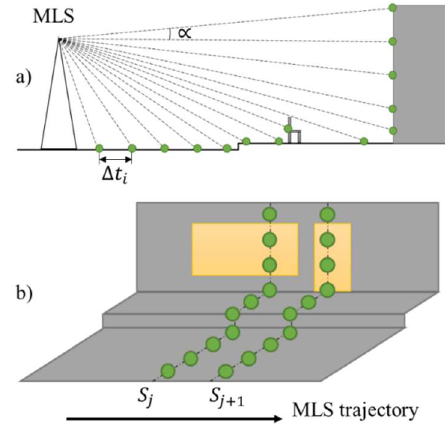
Figure 2: Scanlines of a street in lateral view (a) and isometric